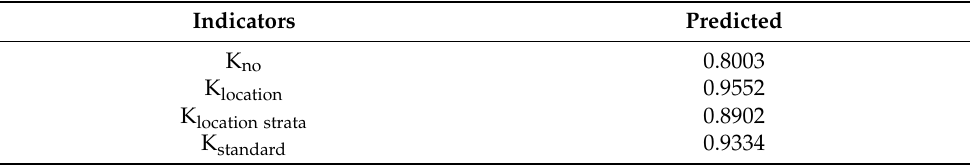
Table 3. Kappa coefficient (index of agreement) of LUCC predicted for